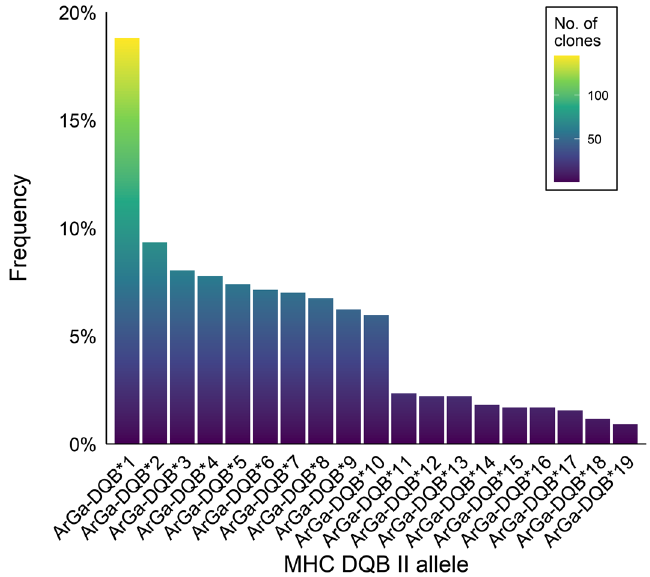
Figure 2. Histogram showing the frequencies of 19 MHC class II DQB exon 2 alleles identified in 56 Antarctic fur seal individuals. Each allele is colour coded according to the total number of clones of that allele in the final cloning dataset, as shown in the accompanying